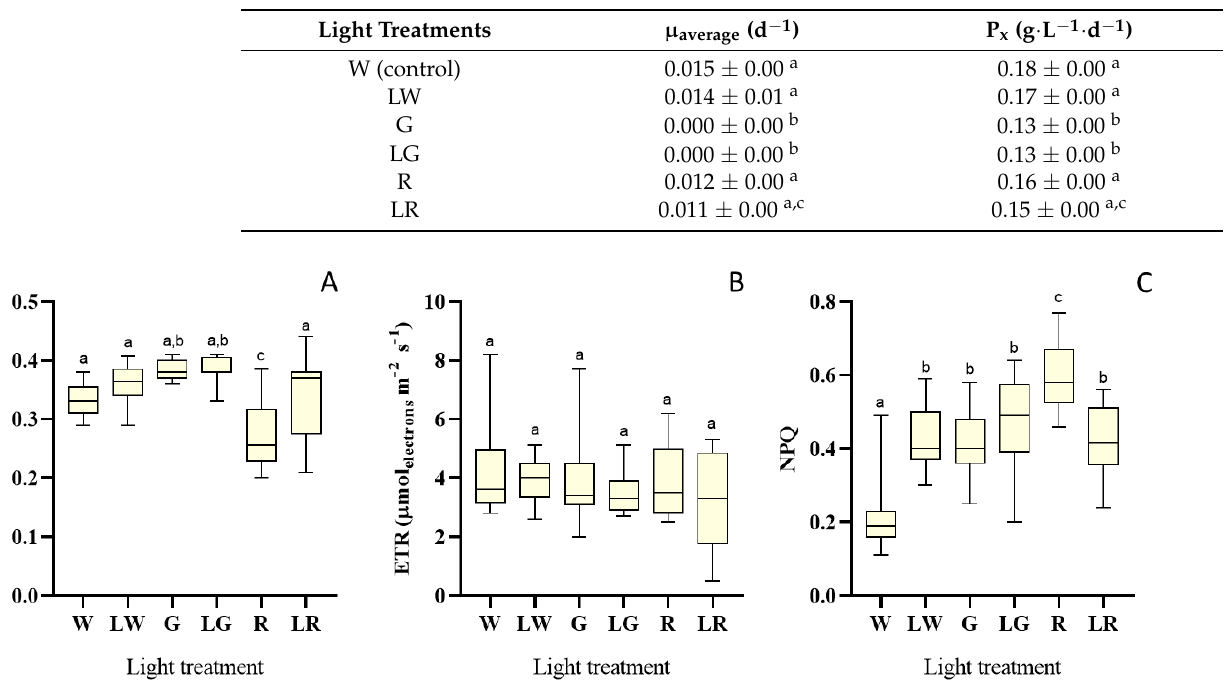
Figure 4. Box and whisker plots of the data of photosynthetic efficiency, for each light treatment: W (white, 150 µ mol photons · m − 2 · s − 1 ) (control), LW (low white, 50 µ mol photons · m − 2 · s –1 ), G (green, 150 µ mol photons · m − 2 · s − 1 ), LW (low green, 50 µ mol photons · m − 2 · s − 1 ), R (red, 150 µ mol photons · m –2 · s –1 ), and LR (low red, 50 µ mol photons · m − 2 · s − 1 ) applied to S. salina LEGE 06155, considering Fv/Fm (maximum quantum yield in PSII) ( A ), ETR (electron transport rate) expressed in µ mol electrons · m − 2 · s − 1 ( B ), and NPQ (non-photochemical quenching) ( C ). The horizontal line within the box indicates the me- dian, boundaries of the box indicate the 25th and 75th quartile, and whiskers indicate the lowest and the highest values of the results. The lowercase letters denote statistically significant differences ( p <